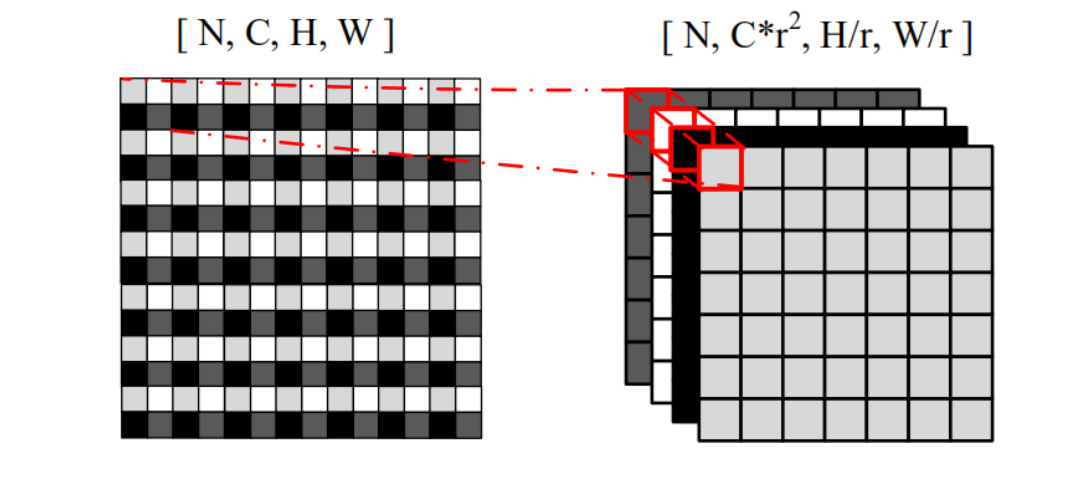
Figure 3. Illustration of the Space-to-Depth transformation.